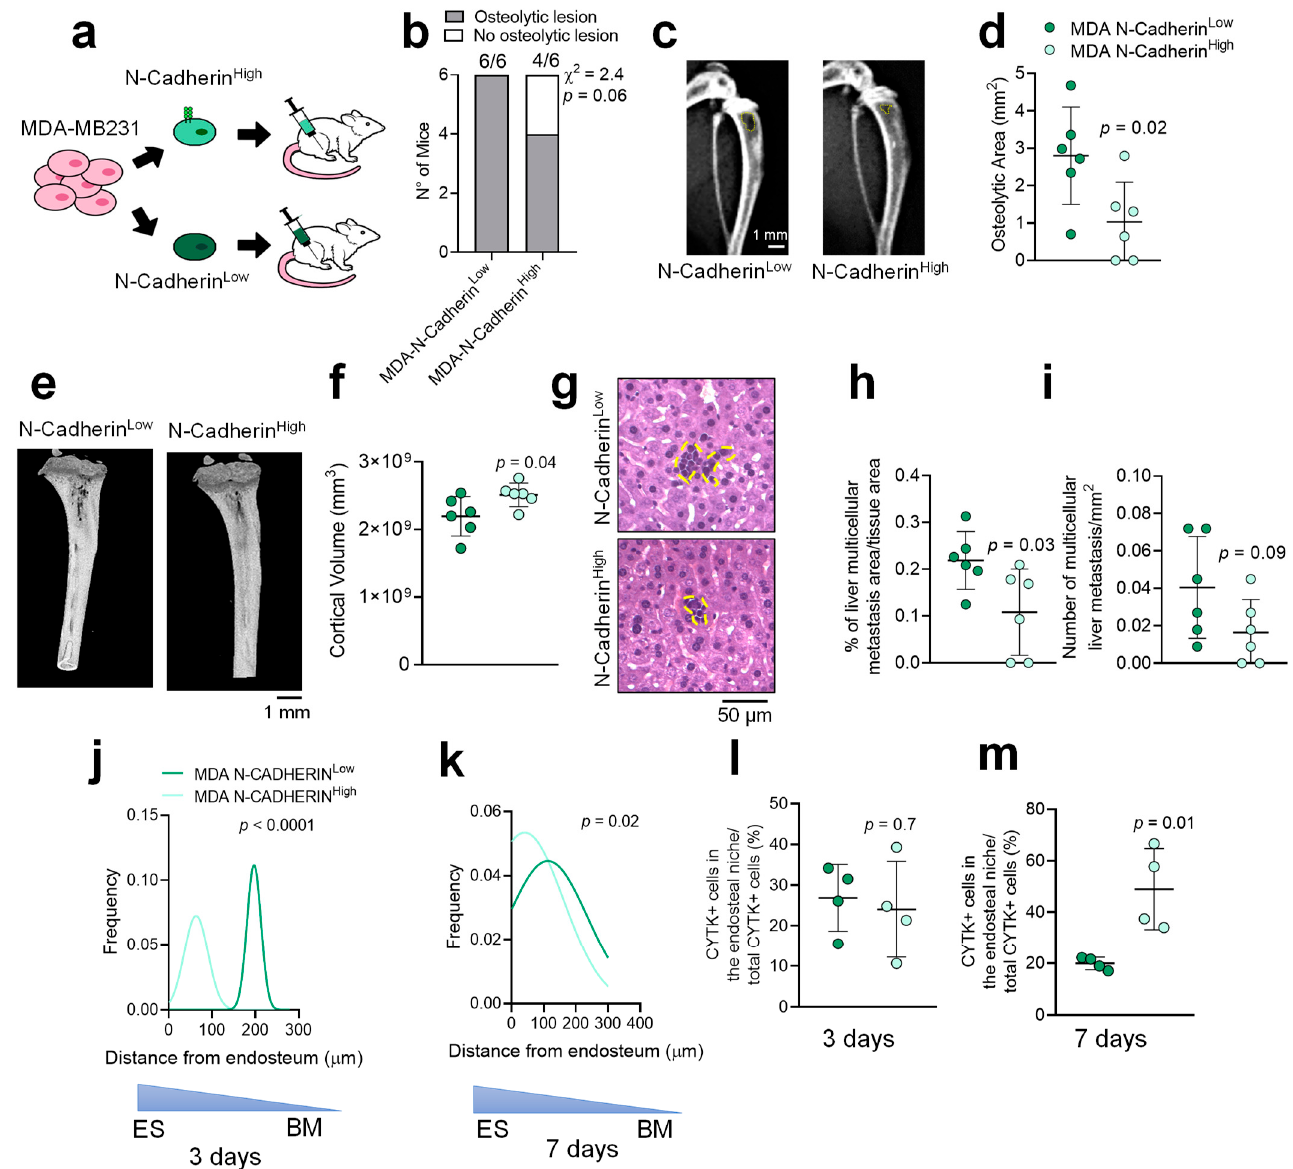
Figure 2. In vivo analysis of N-Cadherin High in MDA BrCa cells. ( a ) Four-week old Balb-c nu/nu female mice were intratibially injected with 1 × 10 4 MDA cells and MACS-sorted into N-Cadherin High and N-Cadherin Low subpopulations. ( b ) After 4 weeks, mice were sacrificed and tibial osteolytic lesion incidence and ( c , d ) area were analysed by X-rays while ( e ) µCT was used to visualize the 3D morphology and ( f ) to measure the cortical volume in the tibia of the injected-mice. ( g ) Paraffin- embedded livers isolated from MDA N-Cadherin High and N-Cadherin Low -injected mice stained with haematoxylin and eosin to quantify ( h ) the multicellular liver metastases area over tissue area (%) and ( i ) the number of multicellular liver metastases over square millimetres by the ImageJ ® software. ( j ) Four-week old Balb-c nu/nu female mice were intratibially injected with 1 × 10 4 MDA cells MACS-sorted into N-Cadherin High and N-Cadherin Low subpopulations and sacrificed 3- and ( k ) 7-days post-injection. ( l ) Paraffin-embedded tibias were harvested from the injected mice immuno-stained for cytokeratin to visualize the tumour cell in the bone tissue and measure the cell distribution in relation to the endosteum, and ( m ) the number of cells in the endosteal niche at the indicated time points. Data are the mean ± SD and pictures are representative of 4–6 mice per group. Statistical analysis: ( b ) χ square analysis, ( d , f , h , i , l , m ) Student’s t -test, ( j , k ) Gaussian curve regression fitting and F-test. Scale bars are shown in the